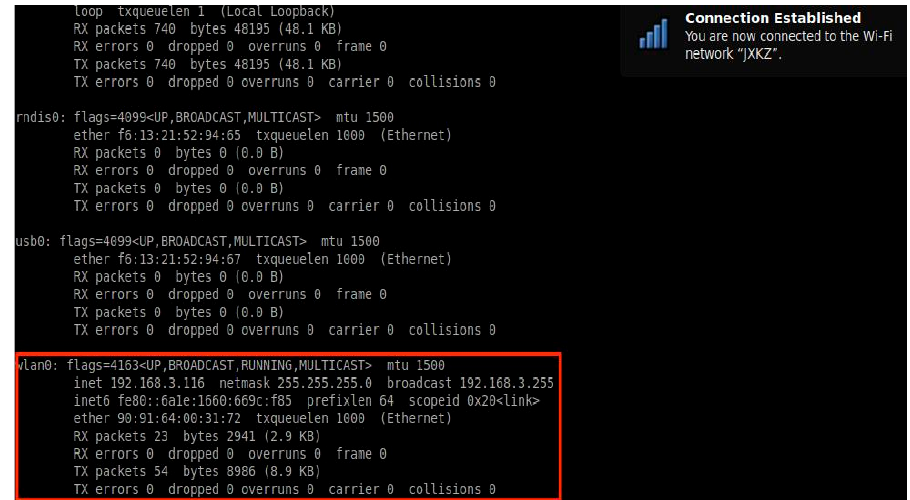
Figure 17. The setup of hardware-in-loop simulation system.